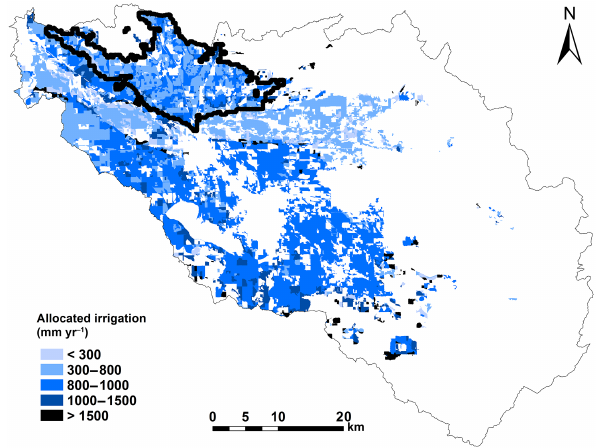
Figure 7. The annual appropriated diversion rates normalized based on water rights maximum allowed diversion rates and place of use, indicating the relative spatial distribution of potential usable water. The irrigation district boundaries and the names of major irrigation districts are also shown.